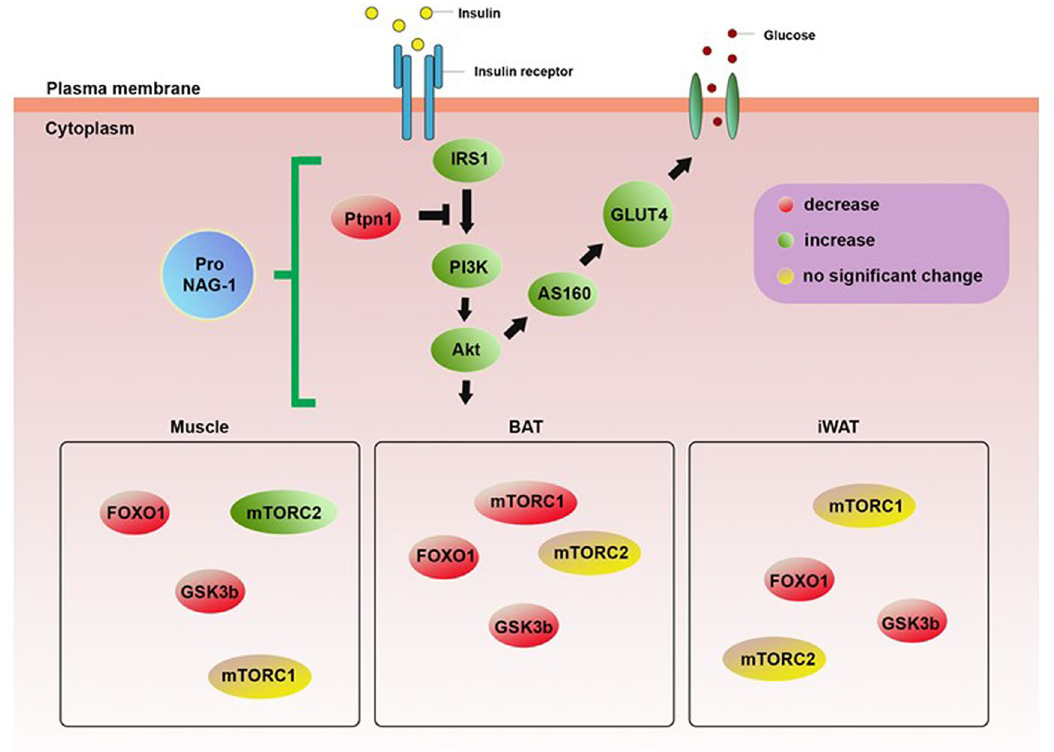
Figure 9. Schematic diagram representing the effect of NAG-1 on the insulin signaling pathway. Overexpression of pro-NAG-1 increases expression levels of IRS1/PI3K/AKT, resulting in anti-diabetic activity. Green and red colors represent upregulation and downregulation, respectively, whereas the yellow color indicates no significantly different